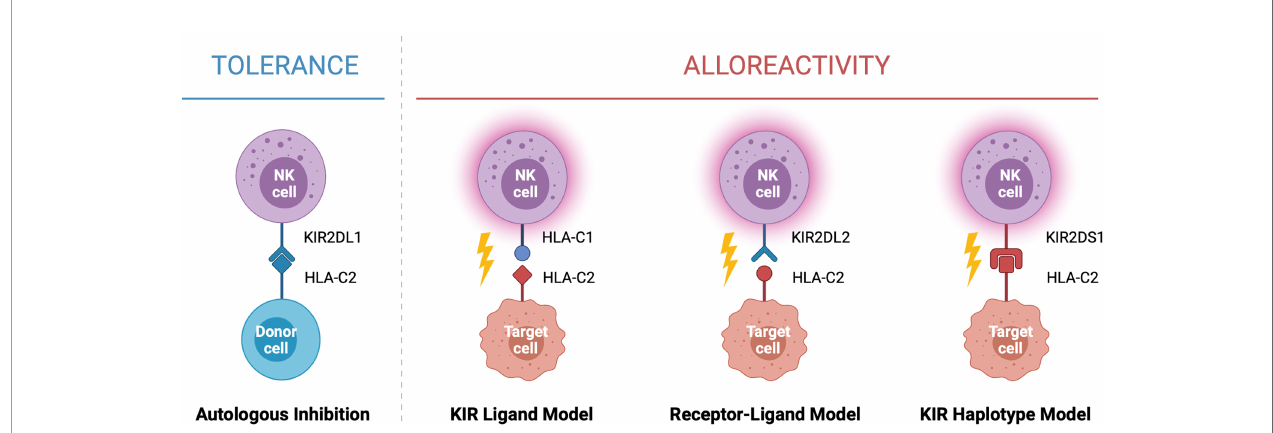
FIGURE 2 | Models of NK Cell Alloreactivity Based on KIR and HLA Expression. Donor NK cells maintain tolerance to self through interactions between inhibitory killer immunoglobulin-like receptors (KIRs) and their cognate human leukocyte antigen (HLA) ligands expressed on healthy autologous cells. In the context of haploidentical HSCT, interactions between donor and recipient KIR and HLA mediate NK cell alloreactivity against target cells. Three models have been described which predict NK cell alloreactivity: mismatch between the donor and recipient HLA (KIR ligand model), mismatch between the donor KIR and recipient HLA (receptor-ligand model), and expression of speci fi c donor KIR haplotypes enriched for activating KIR (KIR haplotype model). When alloreactivity is predicted in the graft- versus -host direction, donor NK cells become activated and carry out cytotoxic effector functions against the recipient ’ s tumor cells. Created with